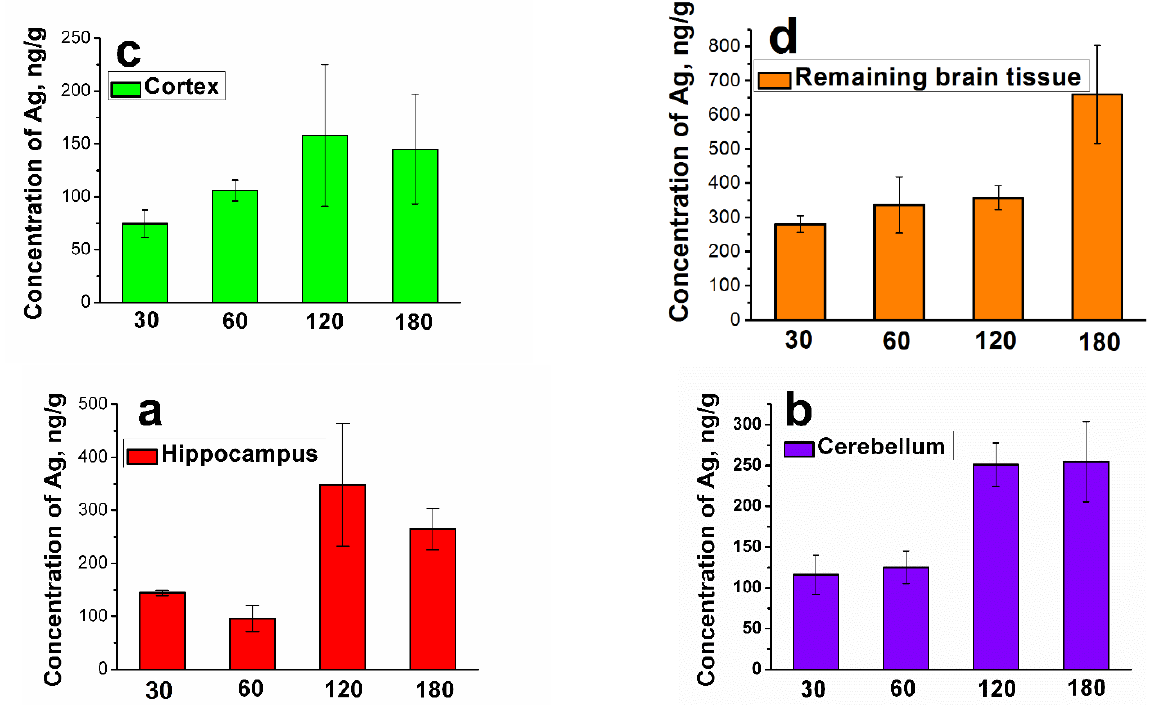
Figure 4. Accumulation of silver in subregions of the brain: ( a ) hippocampus, ( b ) cerebellum, ( c ) cortex, ( d ) remaining brain tissue. Dependencies of the concentration of silver (in ng/g of brain tissue) in the regions of the brain on the period of administration obtained by NAA. A step-like increase in the silver concentration can be seen at 120 days of administration for the hippocampus, cerebellum and cortex and at 180 days for the residual brain tissue. Data are represented as the mean ±